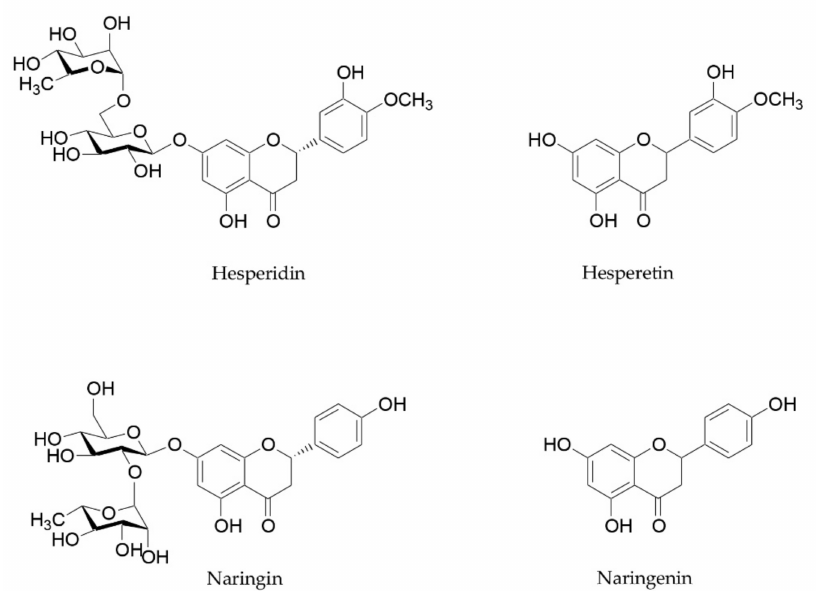
Figure 3. Chemical structure of hesperidin, naringin, and their aglycones hesperetin and naringenin. Büyüktuncel assessed the naringin and hesperidin content in some orange, grapefruit, and tangerine juices by means of the HPLC method. The highest content of naringin was verified in a natural grapefruit juice (323.07 ± 3.45 mg/L), followed by commercial grape- fruit juices and natural tangerine juice, with a content of 56.75 ± 2.01 and 5.39 ± 0.73 mg/L, respectively. Naringin was not detected in commercial and natural orange juice samples and in commercial tangerine juice. For what concerns hesperidin, the highest amount of standard was detected in natural orange juice and in natural tangerine juice (221.70 ± 3.84 and 142.46 ± 2.62 mg/L). Lower amounts of hesperidin were detected in commercial orange juice, commercial tangerine juice, and natural grapefruit juice (26.85 ± 1.82, 12.13 ± 1.10, and 5.53 ± 0.87 mg/L) [95]. Similar results were reported by Ribeiro and coworkers, who detected the highest amount of naringin (476.82 µ g/mL) in a fresh-pressed